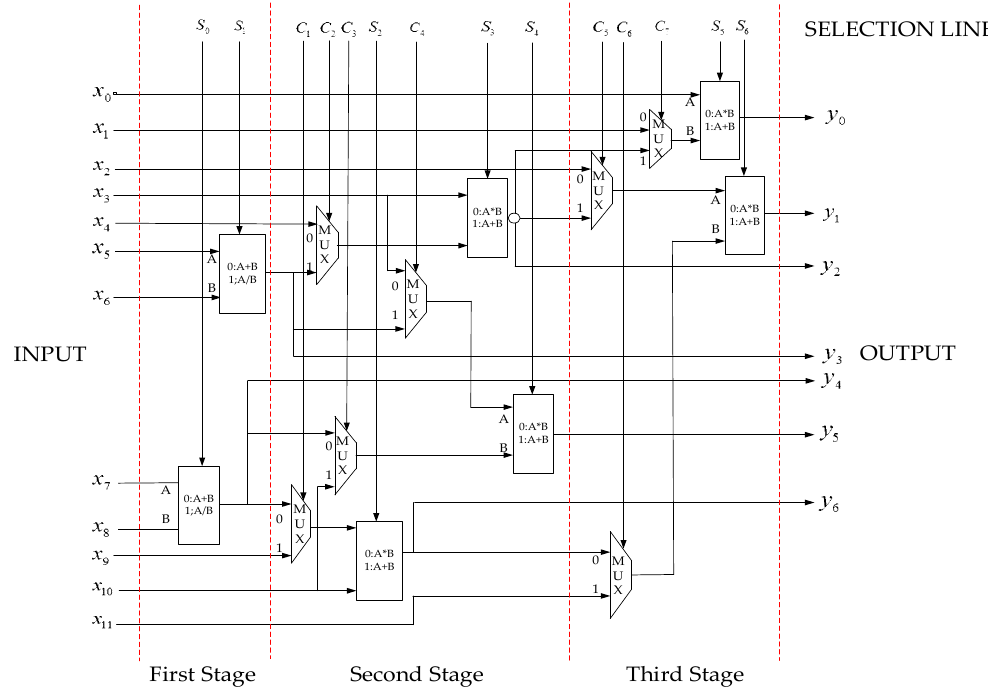
Figure 3. 7-module 3-level series arithmetic expressions circuit.